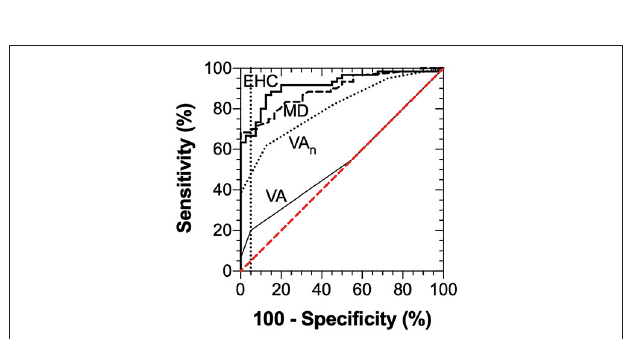
FIGURE 7 | ROC Analysis for visual acuity (AUC: 0.54, 95% CI: 0.43–0.66), visual acuity-in-noise (AUC: 0.81, 95% CI: 0.72–0.89), Mean Deviation of the visual field (AUC: 0.89, 95% CI: 0.83–0.95) and Eye-hand coordination (AUC: 0.92, 95% CI: 0.86–0.97)